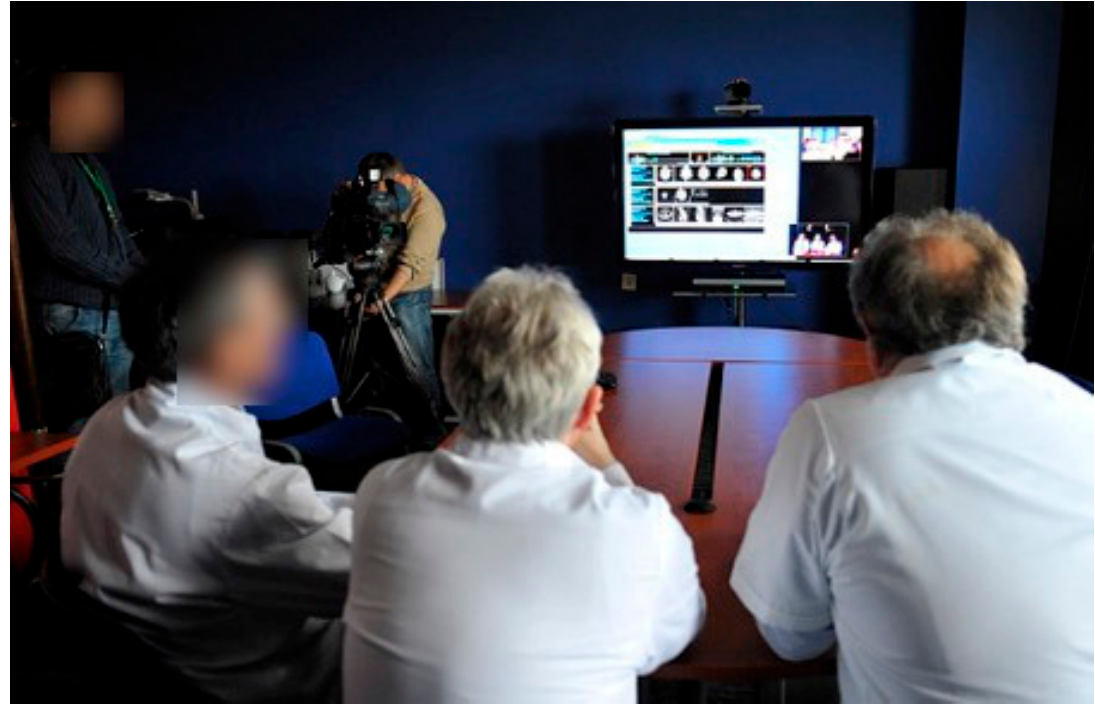
Figure 6. Cross-border meeting (Szczecin/Pasewalk). A working group of the project (in the front of the picture, three participants) and the German members (with modality pictures). From